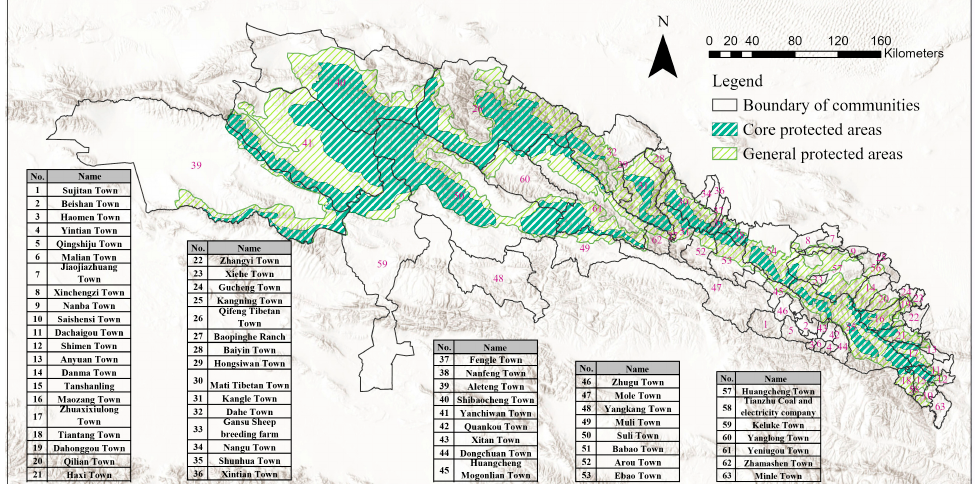
Figure 2. The control zone and the boundary of the township communities of QLMNP (Source: redrawn by author in ArcGIS based on data from the Resource and Environment Data Cloud Plat- form).